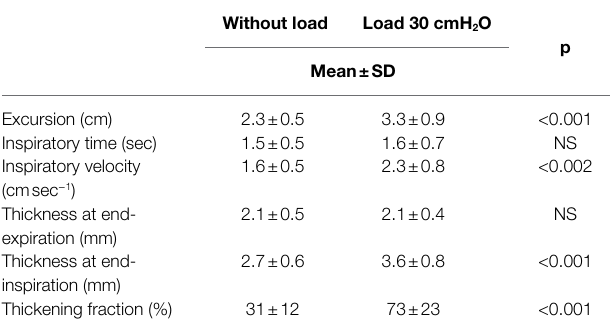
TABLE 1 | Changes in the diaphragmatic parameters induced by a high inspiratory load in volunteers breathing at tidal